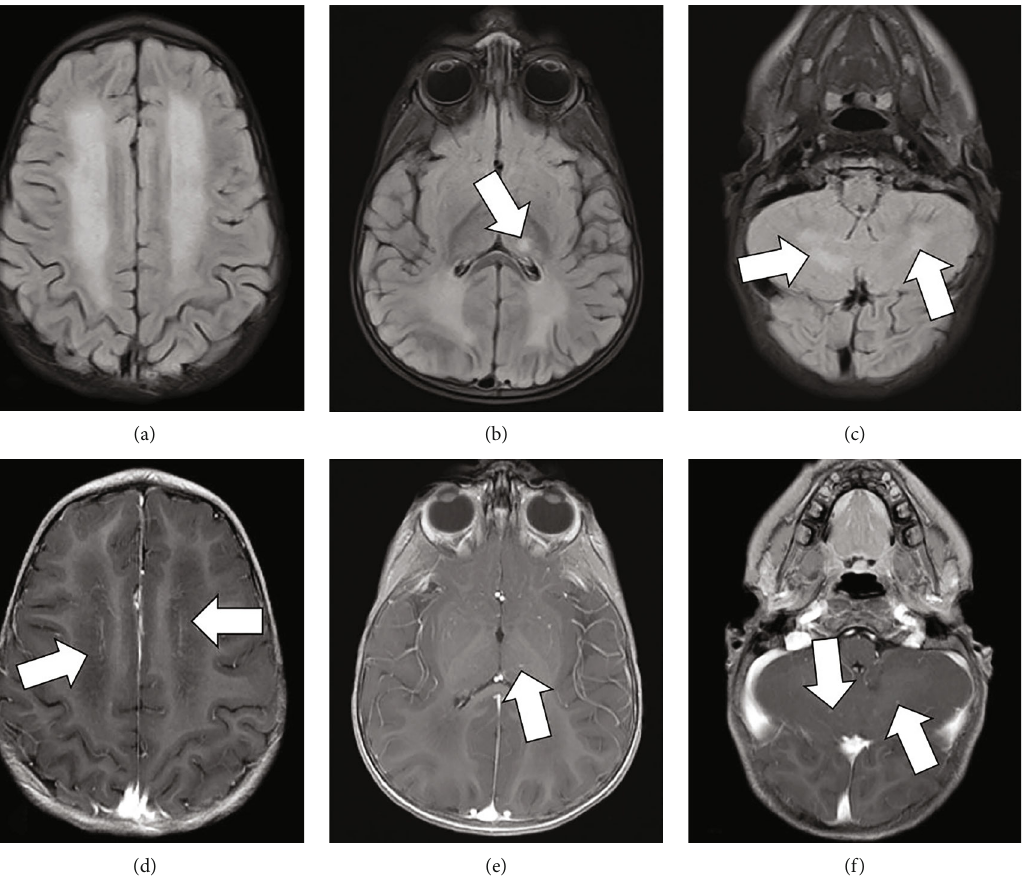
Figure 2: MRI obtained 10 days after admission demonstrating mild progression in di ff use white matter T2 FLAIR hyperintensity (a – c) with slightly increased involvement of the left lateral thalamus (arrow in (b)). Previously noted punctiform enhancement in the supratentorial periventricular white matter has nearly resolved with minimal residual curvilinear enhancement, possibly vessels (arrows in (d)). Small curvilinear enhancement is again seen in the left thalamus (arrow in (e)). Prior curvilinear enhancement in the cerebellum had resolved with interval development of few new punctiform cerebellar enhancing foci (arrows in